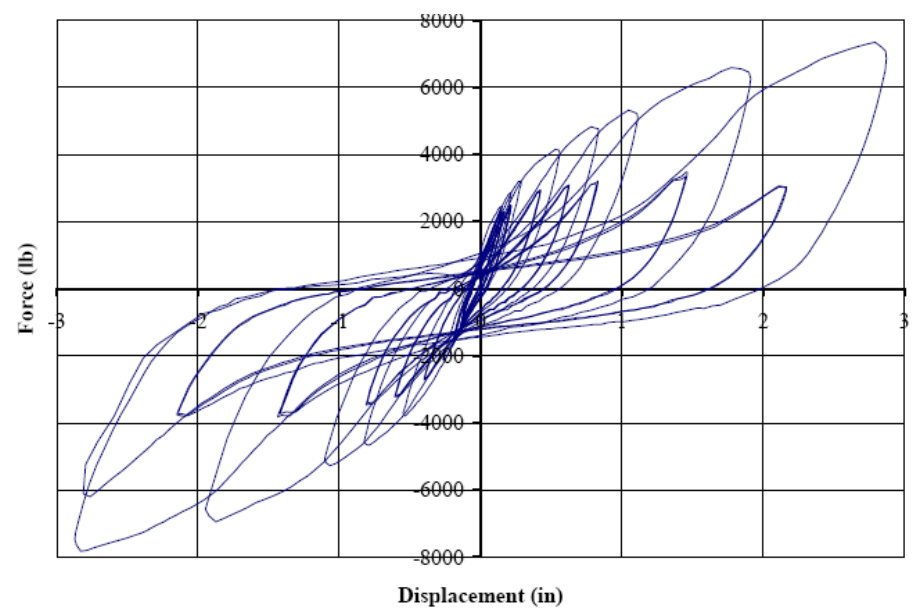
Figure 5. Hysteresis plot for OSBwall 1.